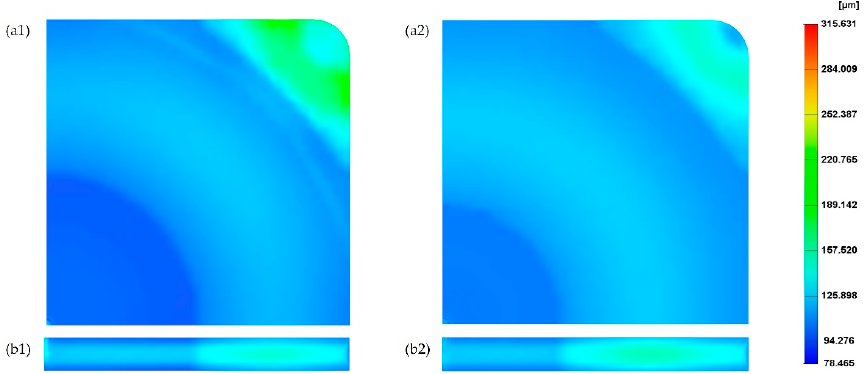
Figure 13. The cell distribution at the surface and cross-section of the MuCell ® part considering a